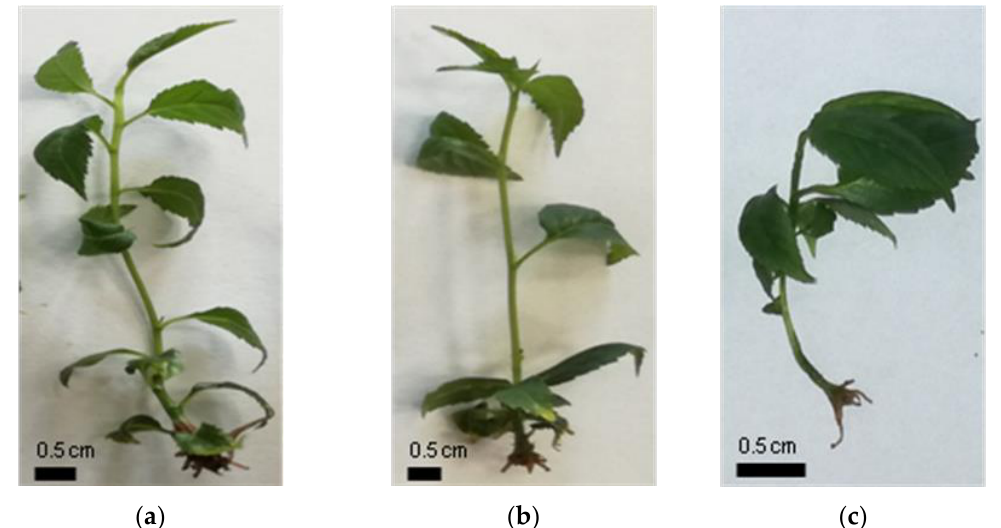
Figure 3. Rooted explants by the effect of ( a ) 1,4-napthoquinone; ( b ) 2-hydroxy-1,4-napthoquinone; and ( c ) p-benzoquinone cultivated in rooting medium in the presence of IBA.